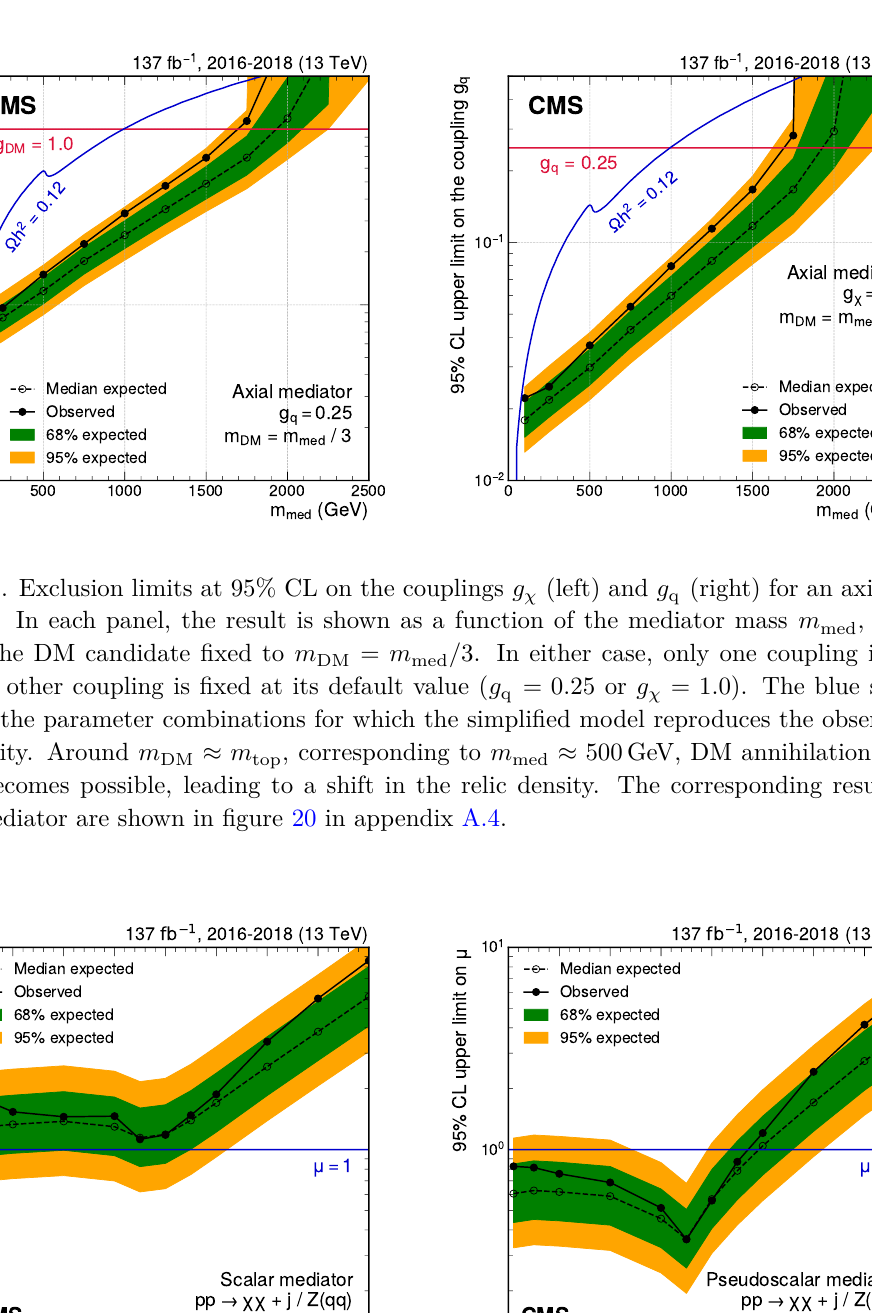
Figure 9 . Upper limits at 95% CL on the signal strength µ = σ/σ narios with scalar (left) and pseudoscalar (right) mediators and coupling values of g for a constant value of m In the case of a pseudoscalar mediator, m